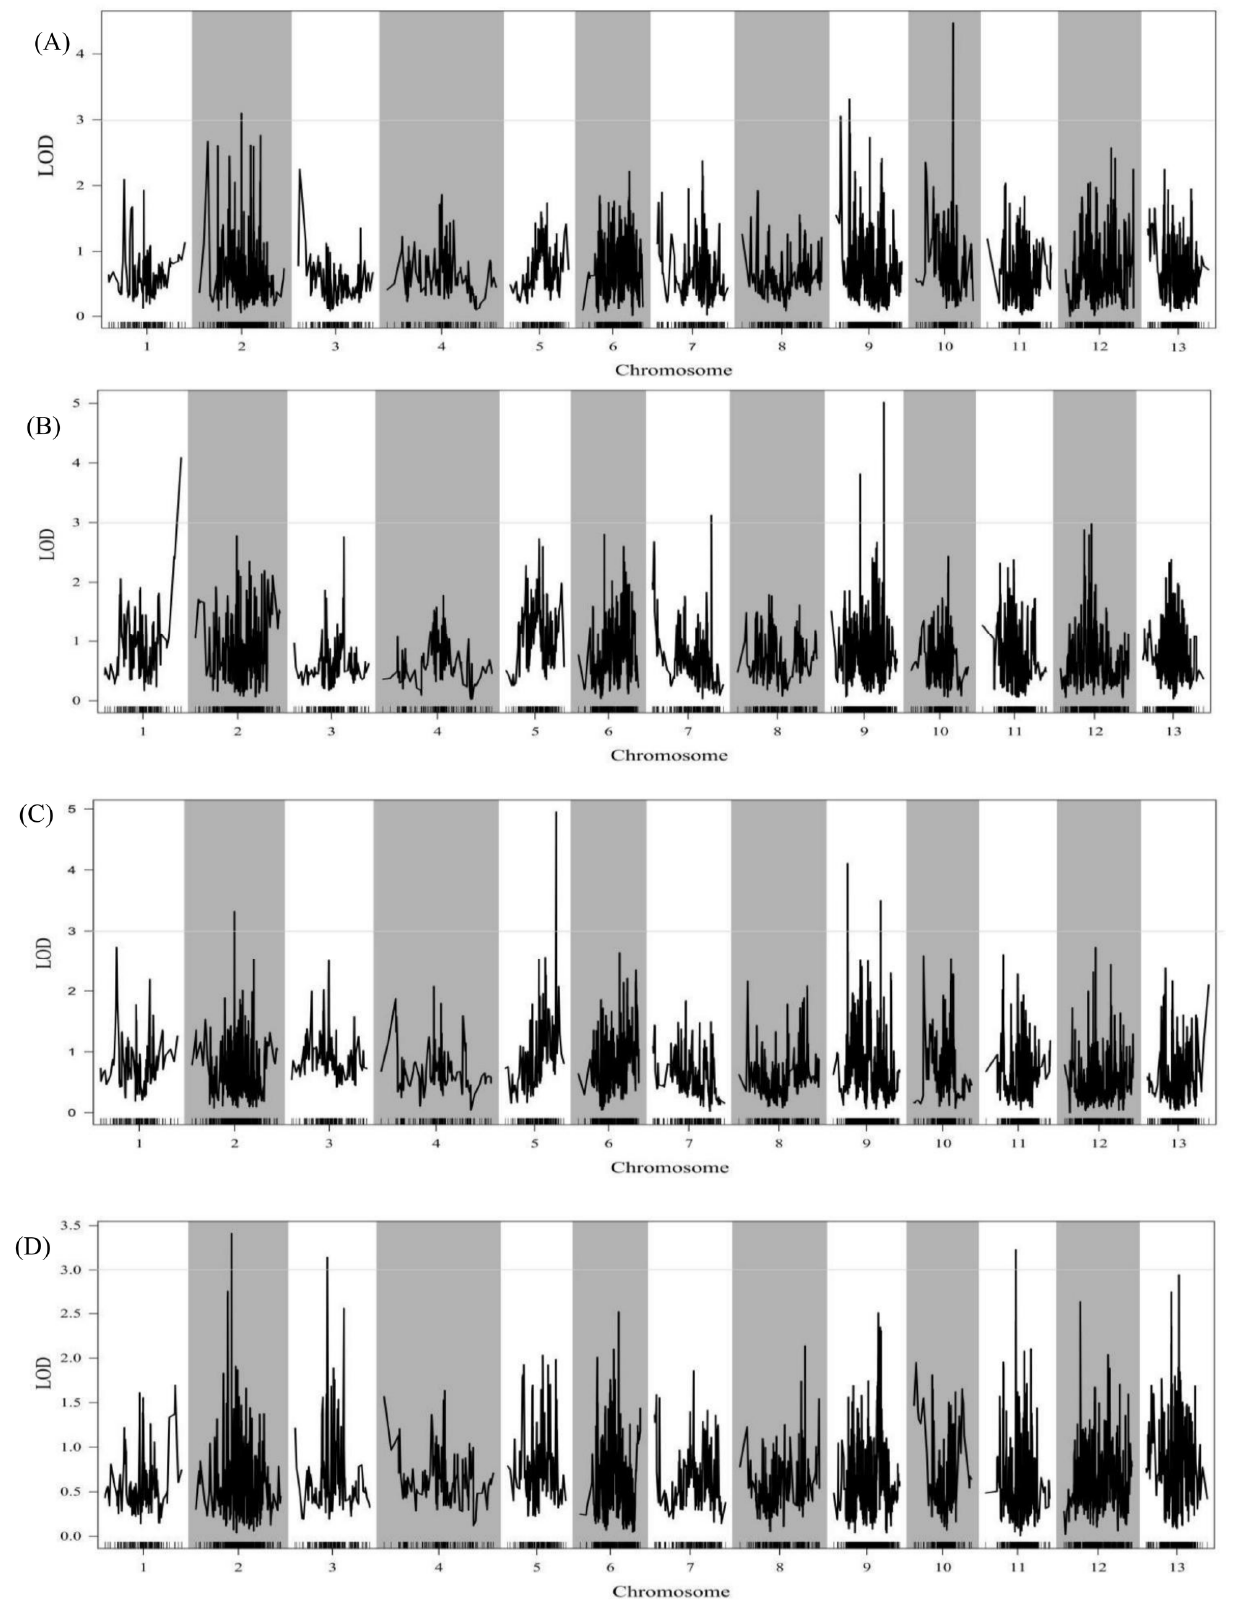
Figure 4. QTLs analysis of four leaf-related traits using the high-density genetic map of Paphiopedilum . ( A ) leaf length, ( B ) leaf width, ( C ) leaf thickness, and ( D ) leaf number.